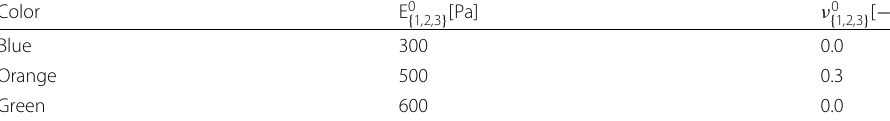
Table3 Initial guesses for different inverse analysis runs in heterogeneous example